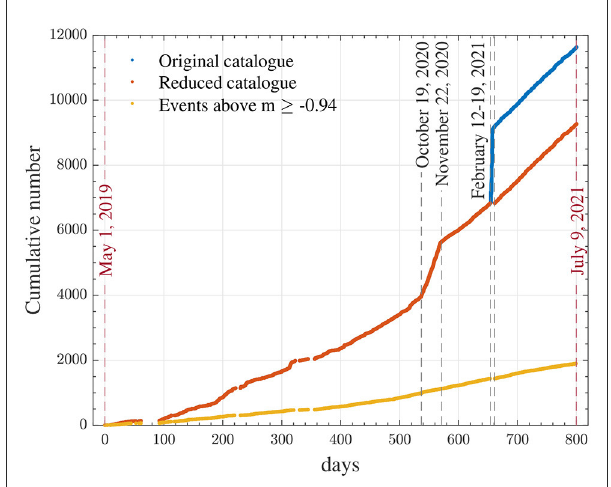
FIGURE2 The cumulative number of events of the mining microseismicity during the study time interval from 05/01/2019 until 07/09/2021. The numbers are plotted as: blue solid symbols for the original full catalog with the events above magnitude m using the reduced catalog, where events associated with the controlled blasts during 12–19/02/2021 were removed; yellow symbols using the reduced catalog for the events above magnitude m ≥ −